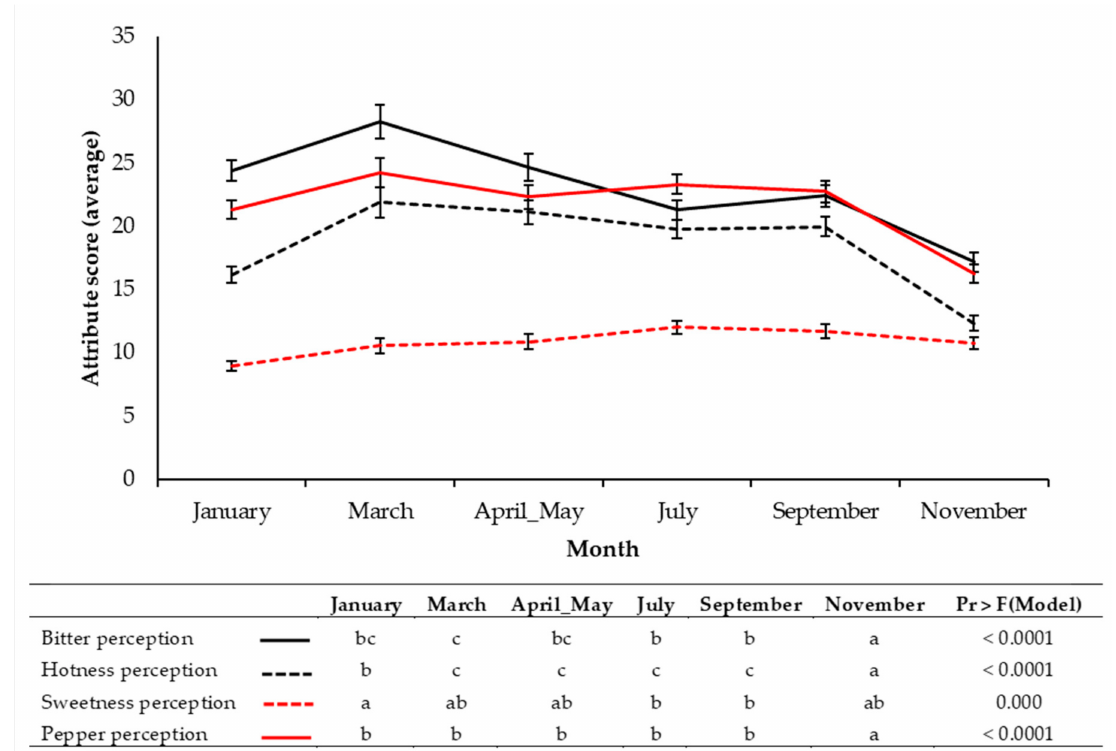
Figure 2. Consumer perceptions of bitter, hotness, sweetness, and pepper attributes of rocket leaves on a bimonthly basis over a growing season. Inset table presents the results of analysis of variance (ANOVA) pairwise comparisons (post-hoc Tukey’s honest significant di ff erence). Significant di ff erences for each perception attribute are indicated by di ff ering lower case letters within rows. See inset for colour coding of attributes. Values are presented as normalized averages of each respective consumer assessment. See Supplementary Table S1 for the numbers of participants in each respective consumer